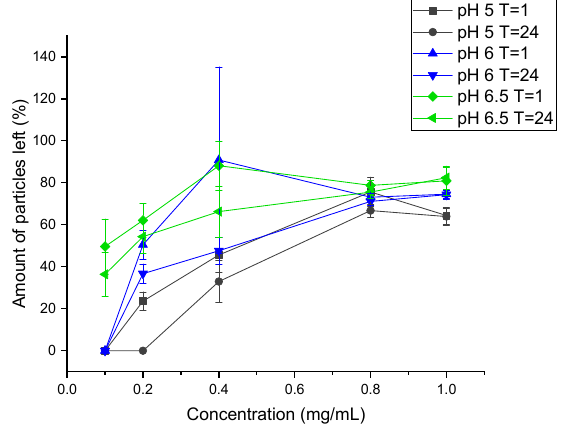
Figure 6. Dissolution of particles measured by absorbance at different time points and pH. (Mean ± SD, n = 3).